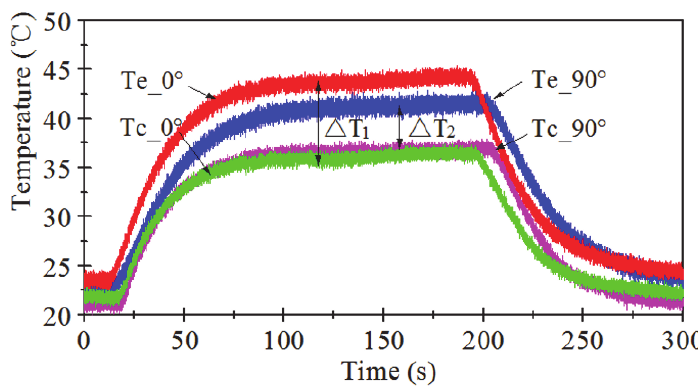
Figure 9. Thermal performance comparison between 0°and 90°.